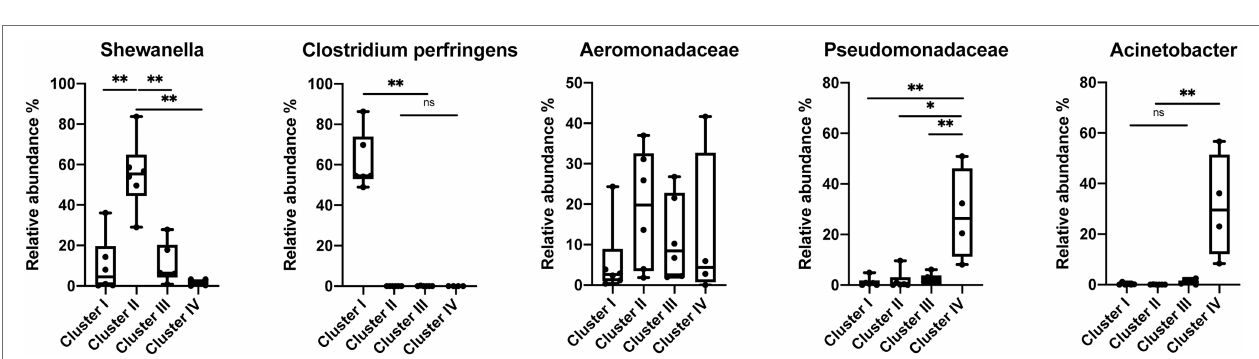
FIGURE 5 | Heatmap of the nematode microbial community at species level. Species with relative abundance >5% across all samples are displayed.